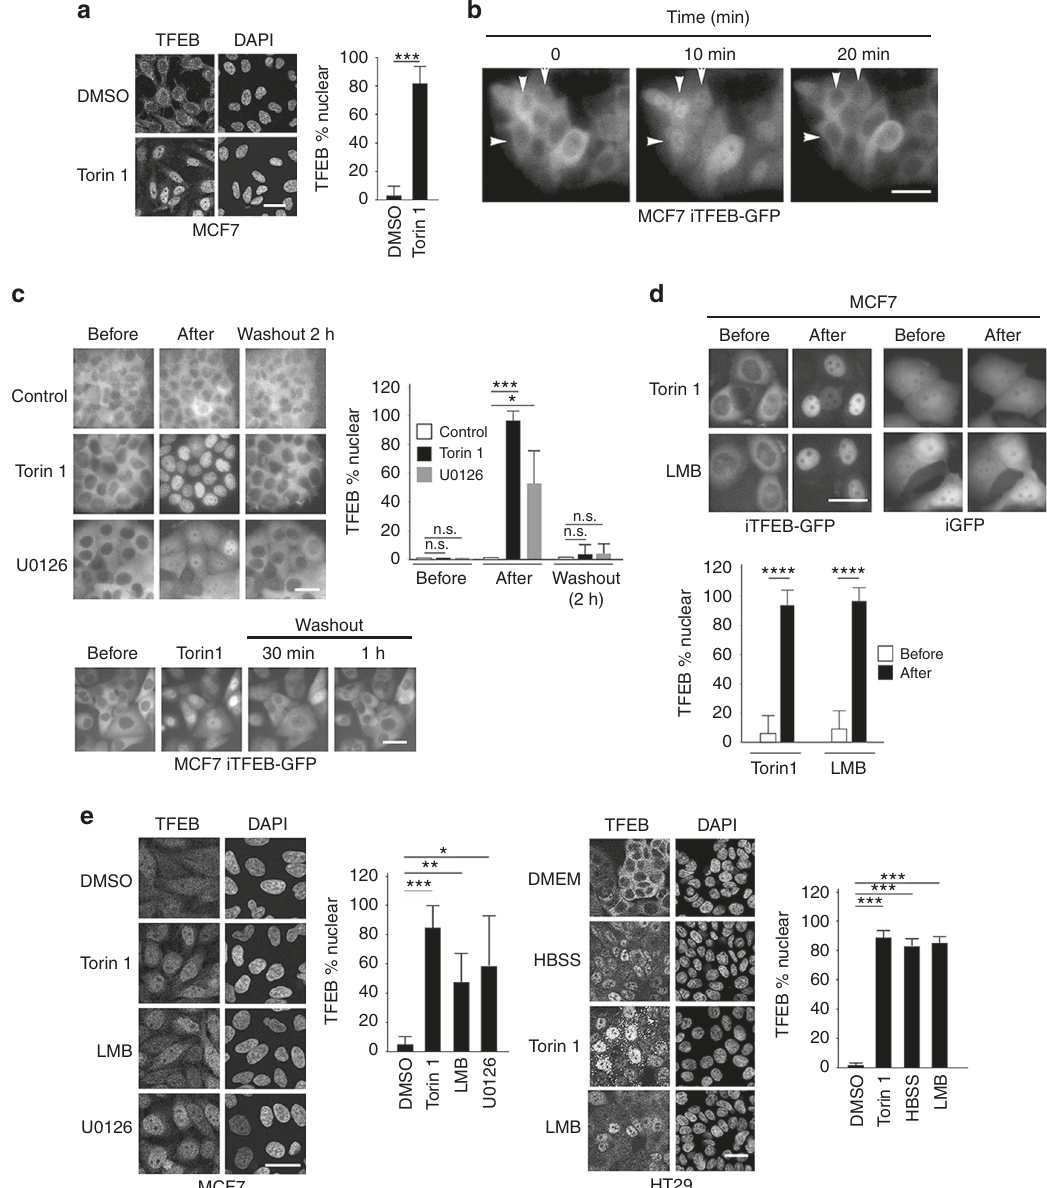
Fig. 1 TFEB is subject to nuclear export. a Immuno fl uorescence with indicated antibodies using control MCF7 cells or those treated with Torin 1 (250 nM, 1 h). n > 30 cells per condition. b Real time imaging of MCF7 stable cell lines expressing doxycycline-inducible TFEB-GFP (iTFEB-GFP) imaged at indicated intervals in the absence of doxycycline. Images derived from Supplementary Movie 1. c Live cell imaging of MCF7 iTFEB-GFP cells before and after 1 h Torin 1 (250 nM) or 2 h U0126 (20 μ M) treatment or after removal of the drug (upper panels) as indicated, or 30 ′ and 1 h after removal of Torin 1 (lower panels). n > 30 cells per condition. d Imaging of MCF7 iTFEB-GFP or iGFP cells before and after LMB (2 h; 20 nM) treatment. Quanti fi cation is derived from one experiment that is representative of 2 independent experiments. n > 30 cells per condition. e Immuno fl uorescence using MCF7 or HT29 cells and indicated antibodies with or without treatment with Torin 1 (1 h; 250 nM), LMB (2 h; 20 nM), and U0126 (3 h; 20 μ M). n > 500 cells per condition. Details of all quanti fi cations including number of replicates and cells imaged are provided in Supplementary Table 1 and Methods. Scale bars = 20 μ M. Error bars = SD. Student ’ s t -test; * P < 0.05, ** P < 0.01, *** P < 0.001, **** P < 0.0001, n.s. not signi fi